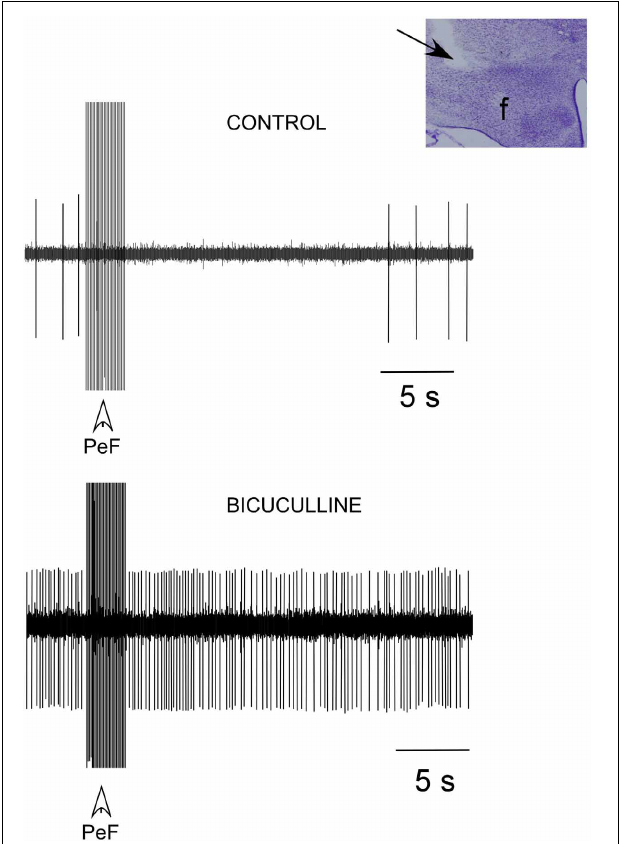
FIGURE 4 | PeFLH stimulation inhibited PnO neuronal activity. A train of electrical stimuli (50Hz; 50 μ A; 500ms of duration) in the PeFLH area (vertical arrow) evoked a long-lasting inhibition of PnO neurons (upper trace). The inhibitory effect was blocked by the iontophoretic application of the GABA A receptor antagonist bicuculline (10mM) into the PnO nucleus (lower trace). Inset shows the stimulated PeFLH area in the Nissl stained section